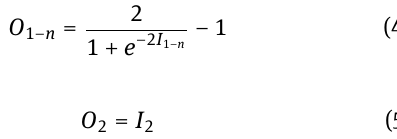
From the MSE results, in general, the Bayesian Regu- larization has the lowest average performance, with MSE of 28.45 compared to the other training algorithm. For iden- tical hidden layer numbers, the lowest MSE is observed when the delay is 2 in all training algorithms except the Scaled Conjugate Gradient. For equal delay, the more the hidden layer numbers, the lower the MSE except for the re- sult of the Scaled Conjugate Gradient training algorithm.